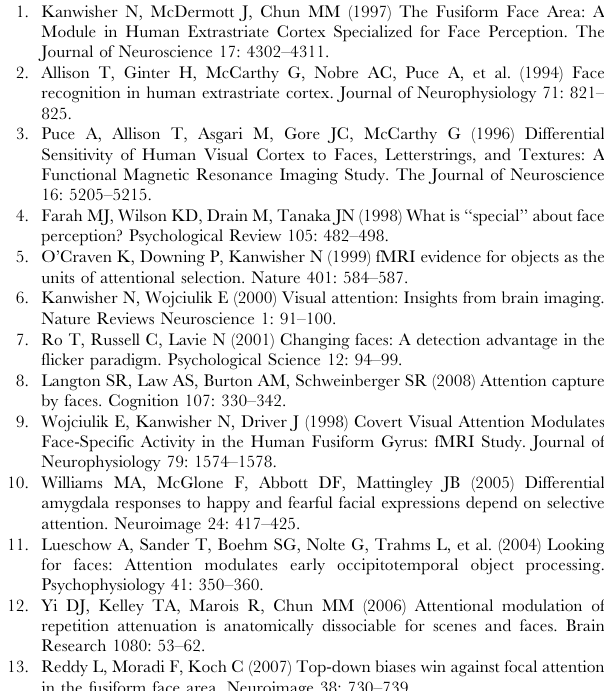
Figure S1 Correlation of the MCE and d’ for prime-cue (A), target-cue (B), and no-cue (C) trials. To assess whether the MCE in Expt 1A systematically varied with prime visibility, we calculated a Standardised Priming Index (SPI) using peak xy deviation, and regressed SPI over participants’ d’ scores for each cue condition. The relationship did not reach significance for any of the cue conditions. Figure S2 Conditional mean durations of the initial 30% of Expt 1A trajectories, shown as a function of Target-Viewing Time. Our primary analysis for Expt 1A examines how x -velocity (averaged over the initial 30% of trajectory responses) varies with Target-Viewing Time (i.e. LiftOff Latency). Here we present the conditional mean duration of this initial 30%. Duration is clearly affected by Target-Viewing Time, in that earlier LiftOff Latencies result in longer trajectory durations and, thus, the initial 30% spans a longer period of time. Since duration varies between trials then, one might think that duration might affect x -velocity during the initial 30%, and that it should therefore be incorporated into our primary analysis.